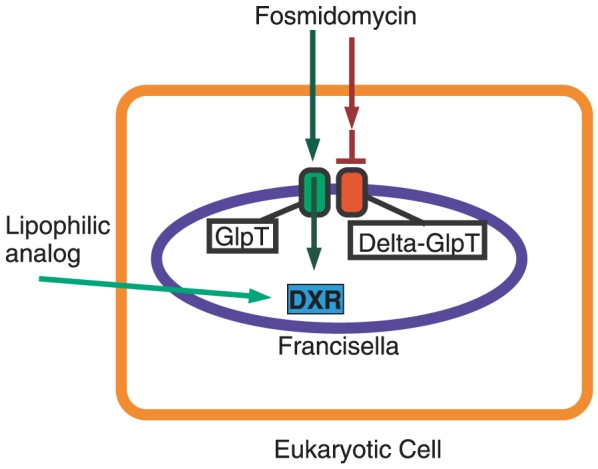
Model for screening method to identify lipophilic, fosmidomycin-derived analogs effective against intracellular pathogens.This is the model for a new screening method for a library of fosmidomycin/FR900098 analogs against host cells infected with intracellular bacteria to identify lipophilic derivatives that can cross both eukaryotic and prokaryotic membranes. In this example, the mammalian cell (orange line) is infected with intracellular bacteria, F. novicida (green GlpT) or F. novicida glpT mutant (red GlpT) separately. If intracellular bacterial growth of F. novicida glpT mutant is inhibited by a compound (inhibition of the DXR enzyme), the fosmidomycin analog is likely able to cross both eukaryotic (orange) and prokaryotic (blue) cell membranes. Such analogs would be good candidates for further testing in other models such as host cells infected with TB. If the analog does not inhibit growth, it may be GlpT-dependent for bacterial cell entry, and thus could not reach the intra-bacterial DXR enzyme in the glpT mutant. This would be verified by further testing against wild-type F. novicida infected host cells. Thus, by screening eukaryotic cells infected with F. novicida glpT mutants, we are able to simultaneously screen for the three critical functional properties of the desired compound (eukaryotic & prokaryotic membrane penetration and GlpT independence).